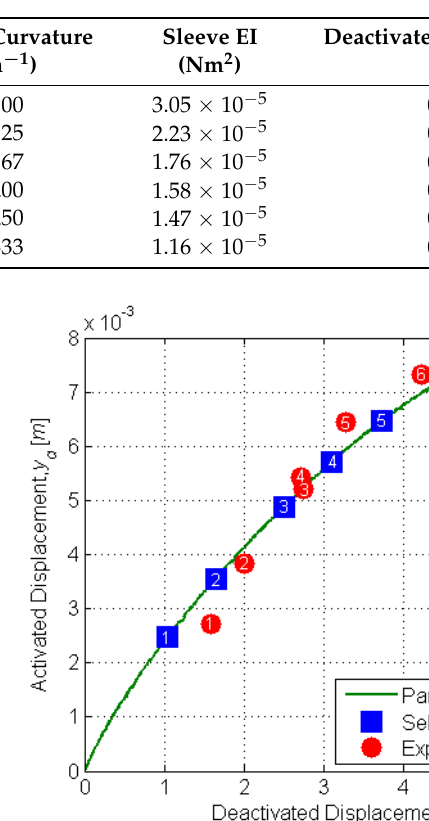
Table 5. Selected Pareto-optimal designs for experimental validation.